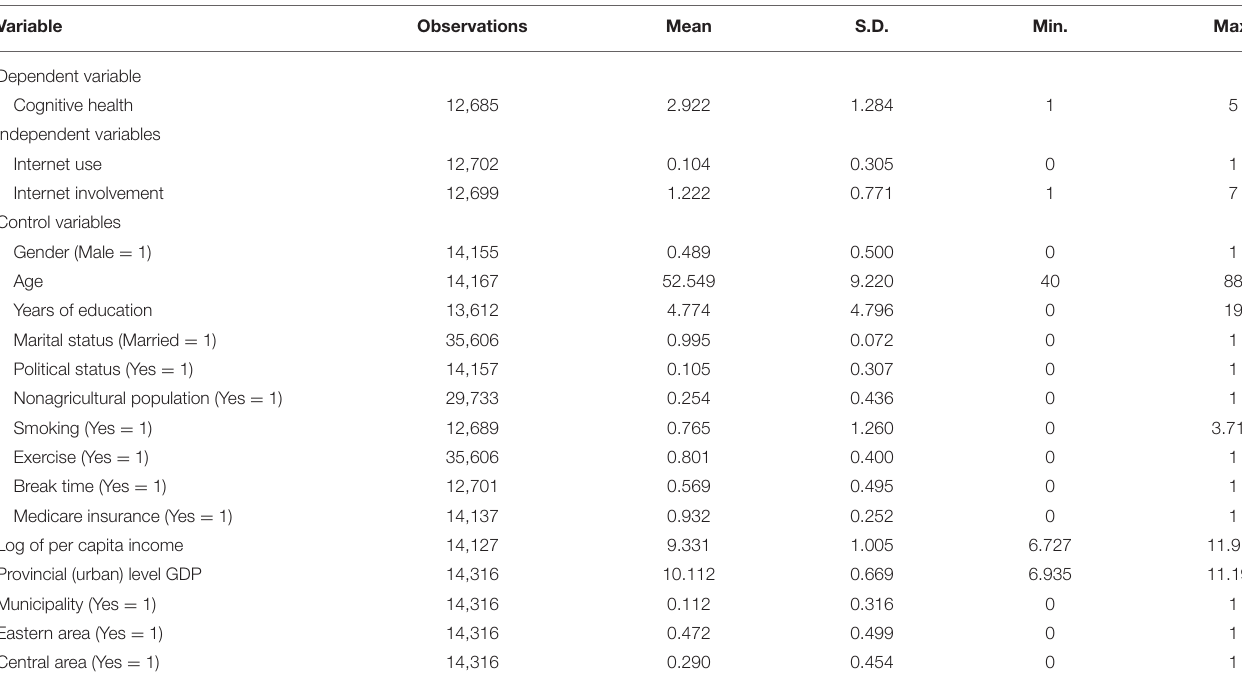
TABLE 1 | Descriptive